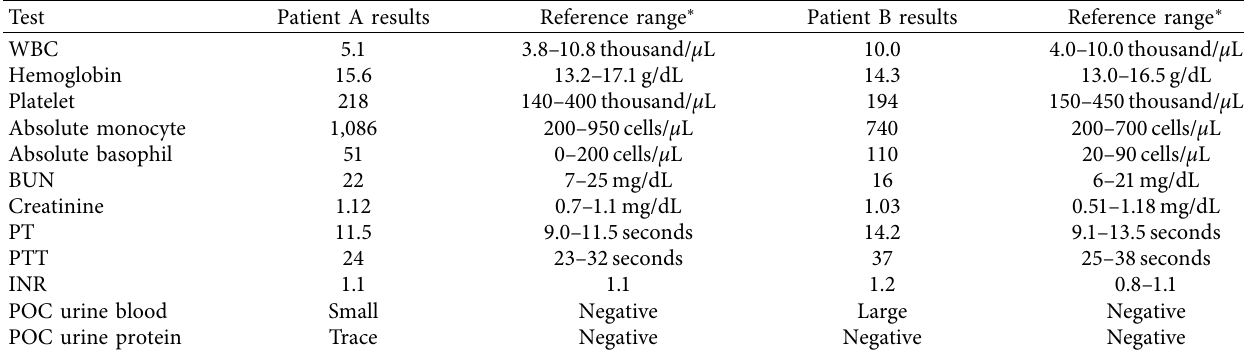
Table 1: Laboratory